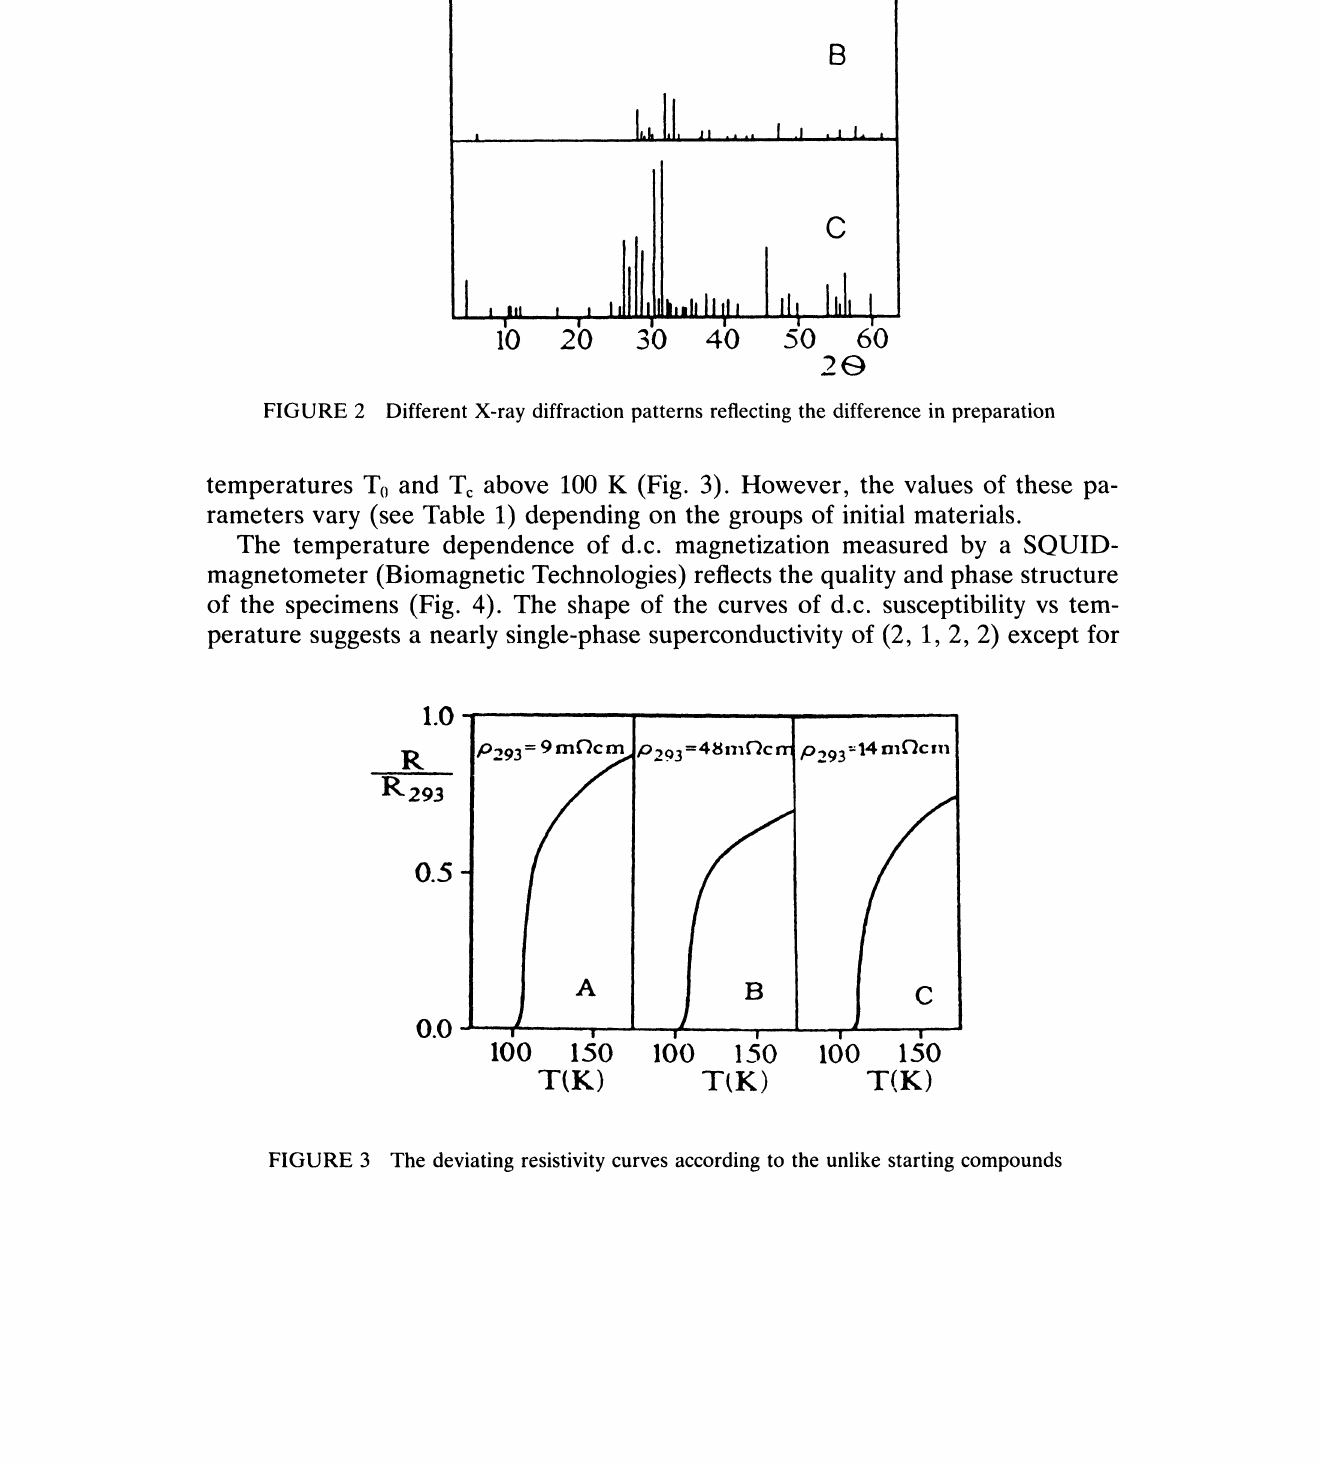
FIGURE 3 The deviating resistivity curves according to the unlike starting